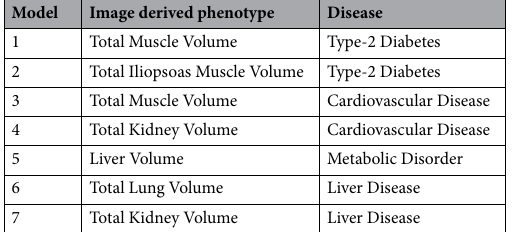
Table 2. Linear mixed-effects models by number, specifying the image derived phenotype (IDP) and disease